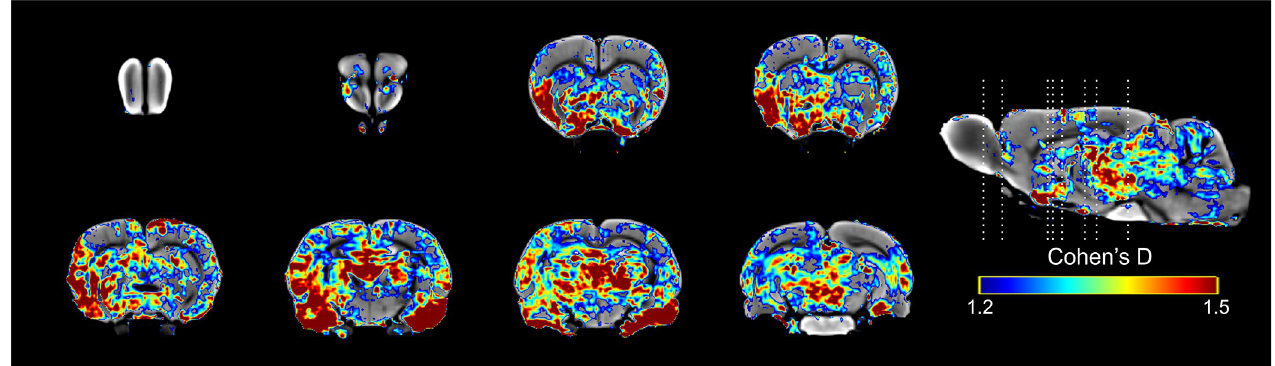
Fig 12. Results of the Cohen’s D analysis from the comparisons of sexual behavior group with 16 mg/kg in session 10 against its session 5.